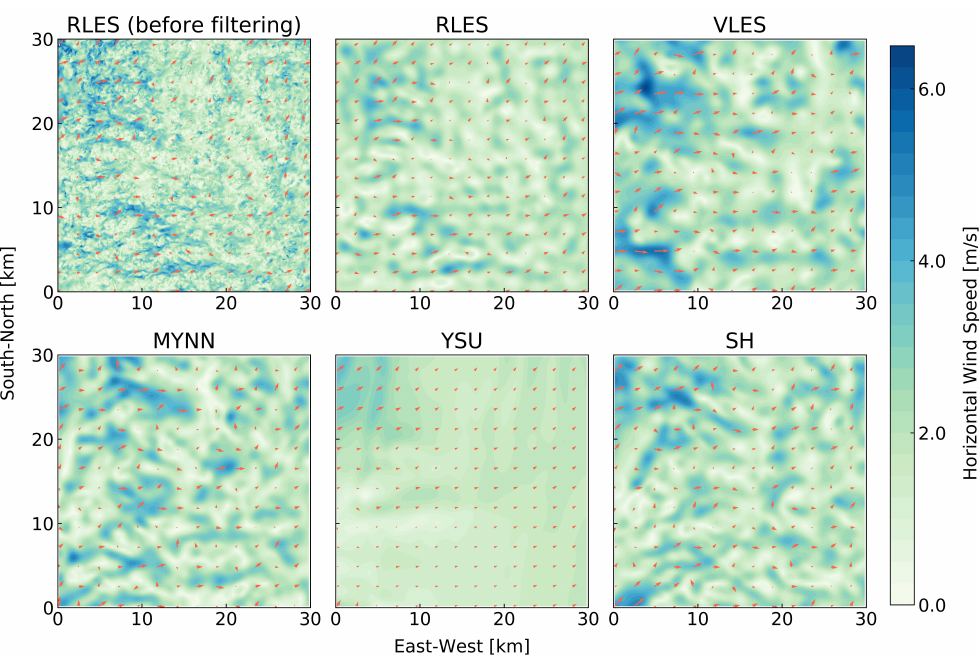
Figure 15. Contours of horizontal wind speed and wind direction vectors at z / z i = 0.5 for all simulation strategies on 21 March, 2100 UTC (1500 LT). This time represents a peak in − z i / L , as shown in Figure 4d. For completeness, RLES is shown before and after spatial